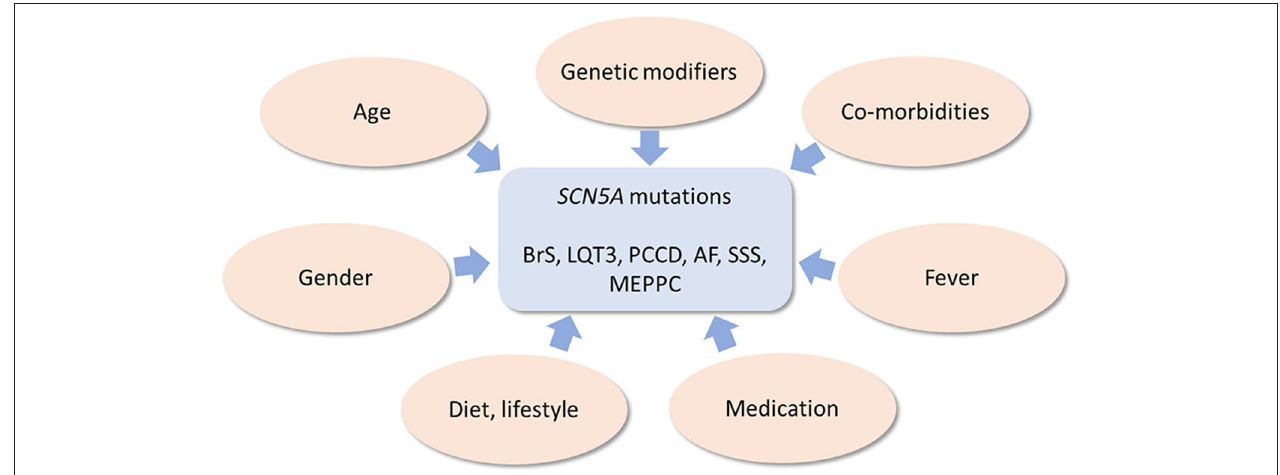
FIGURE 3 | Schematic drawing of genetic and non-genetic disease modifiers of inherited cardiac SCN5A